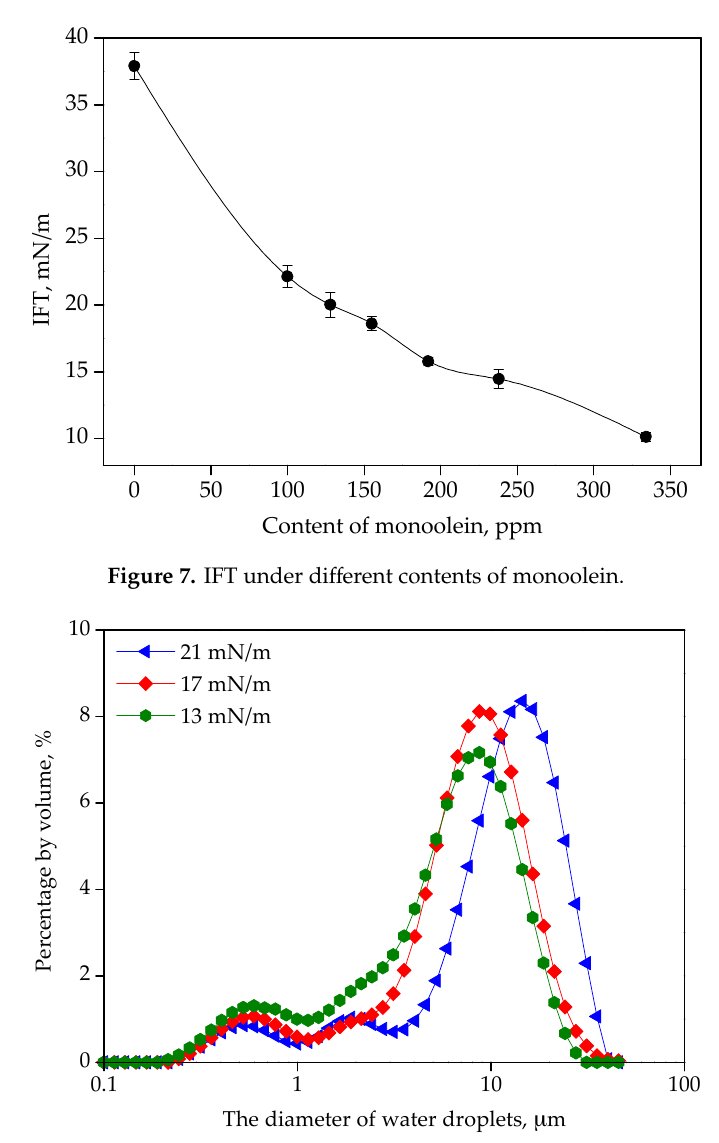
Figure 8. The size distribution of water droplets in diesel under different IFT.